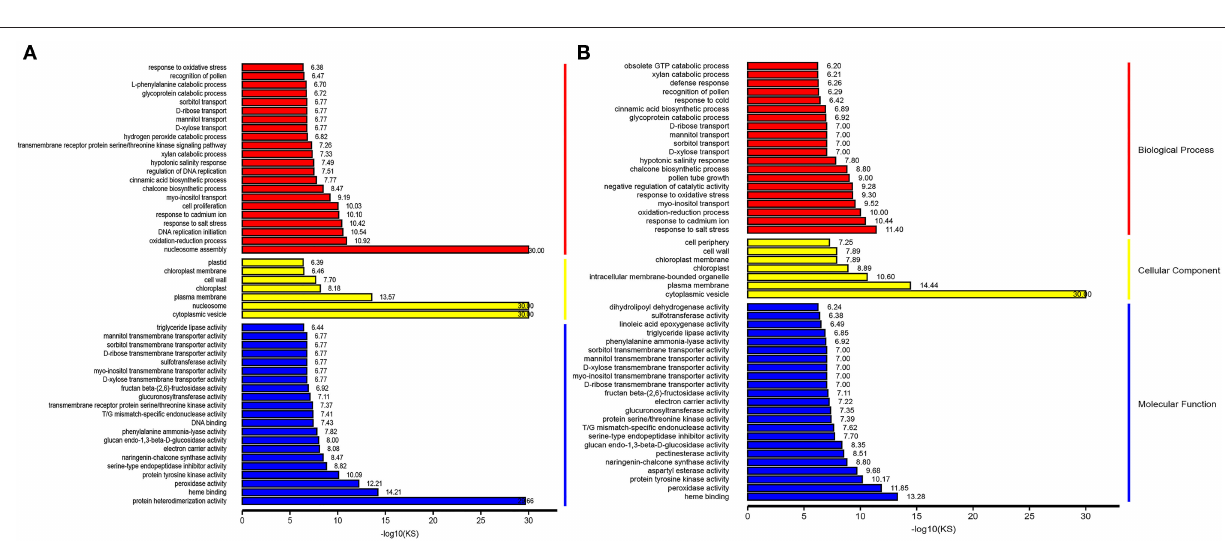
FIGURE 5 | Representative images showing top enrichment gene ontology (GO) terms of the differentially expressed gene (DEGs). Red color, yellow color, and blue color indicates a biological process, cellular component, and molecular function, respectively. (A) Upregulated DEGs in Normal and HT-ms anthers. (B) Downregulated DEGs in Normal and HT-ms